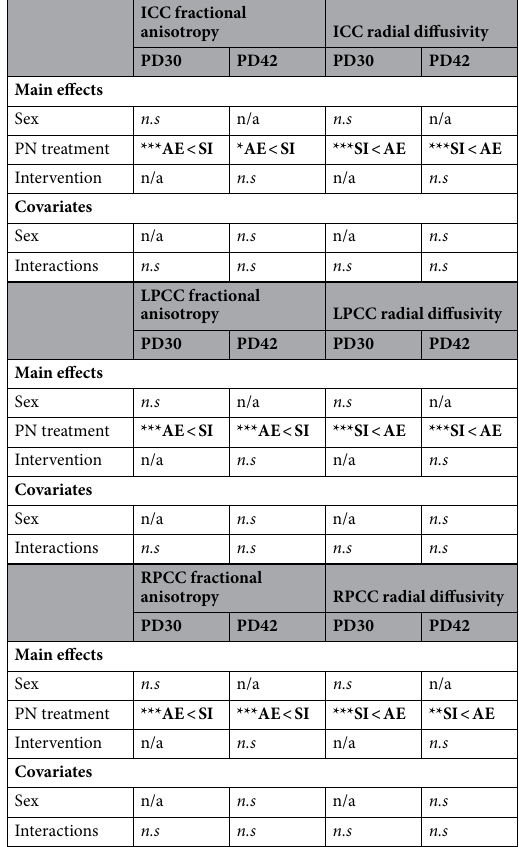
Table 3. Cross-sectional analysis of ICC and left/right PCC fractional anisotropy and radial diffusivity data collected on PD30 and 42. Significant values are in bold. *** p < .001, ** p < .01, * p < .05; n/a variable not included in analysis, n.s. non-significant